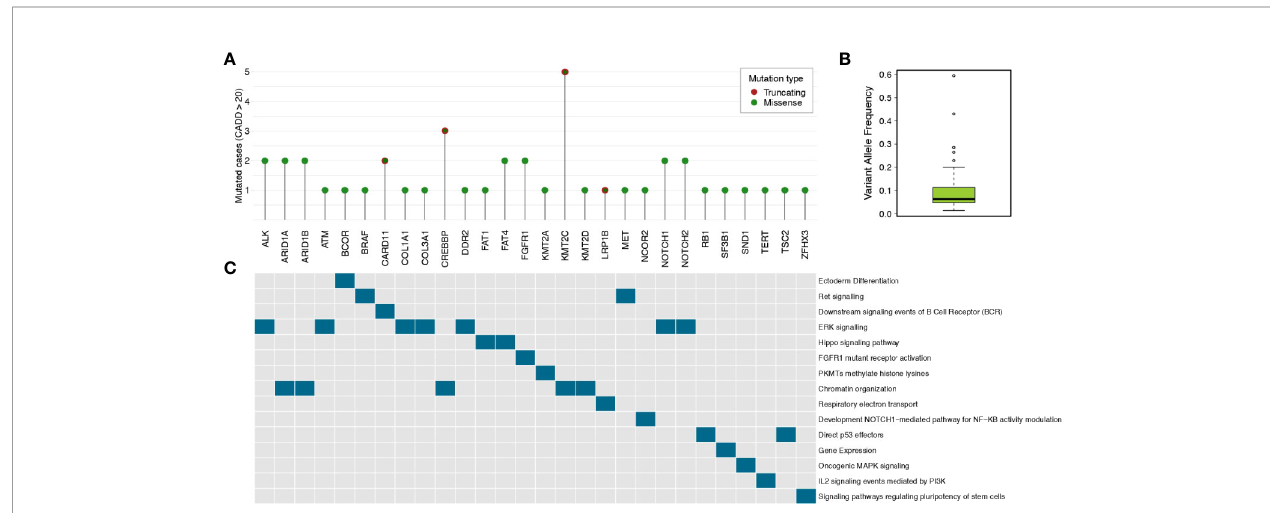
FIGURE 2 | Highly pathogenic somatic mutations. (A) The lollipop plot shows the number of cases for genes having somatic mutations with pathogenicity scores higher than 20 as determined by CADD tool. (B) The box plot reports the median variant allele frequency of the selected somatic mutations. (C) The data matrix shows the pathways in which the mutated genes are involved